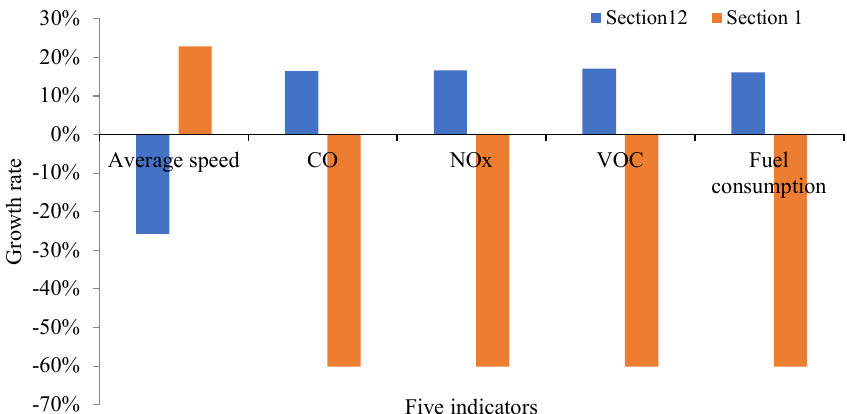
Figure 27. Optimization comparison at Section 12 and Section 1.